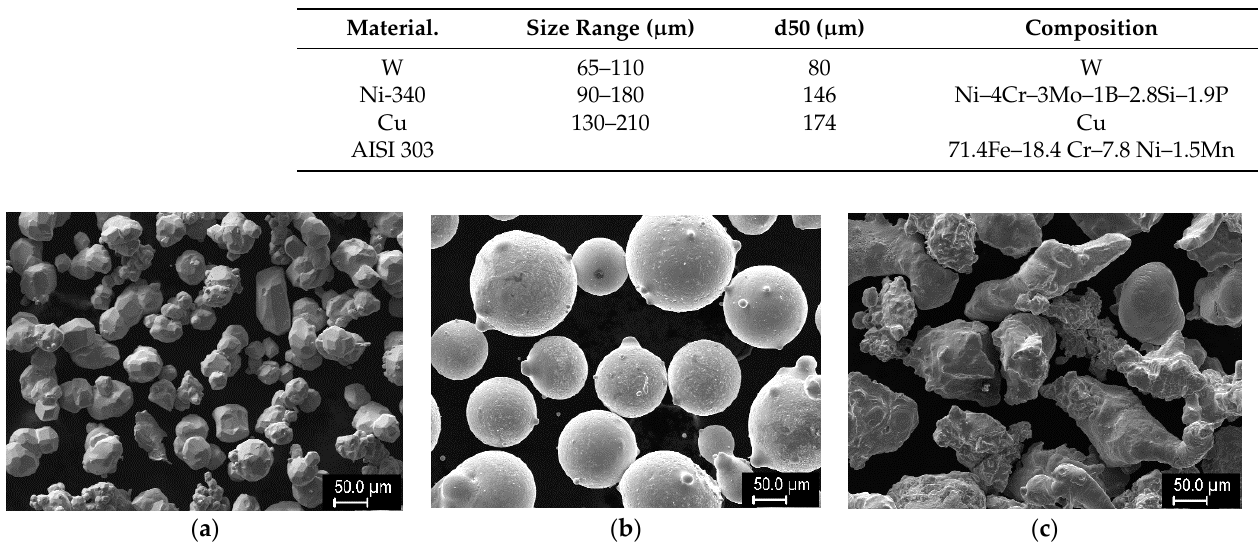
Figure 1. Morphologies of the feedstock powders: ( a ) W, ( b ) Ni alloy, ( c ) Cu.